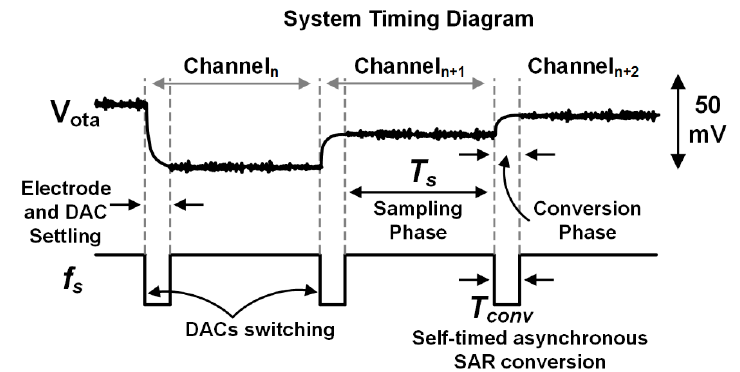
Figure 7. Illustration of the multiplexed recording circuit operation showing the OTA output (top) along with timing information. The OTA DAC provides coarse cancellation of the electrode DC offsets. After a short period of time ( (cid:1846) (cid:3030)(cid:3042)(cid:3041)(cid:3049) ) reserved for settling of the electrode, LNA, and DACs, the electrode signal is integrated onto the input capacitance of the ADC ( C (cid:2893)(cid:2898),(cid:2911)(cid:2914)(cid:2913) ).